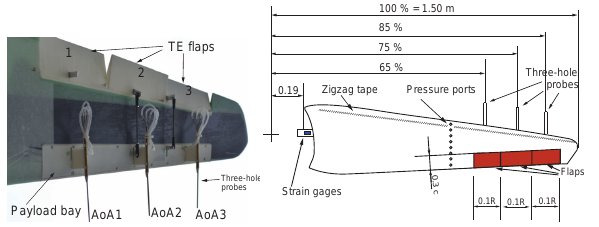
Figure 4. Smart blade, modified from Bartholomay et al.